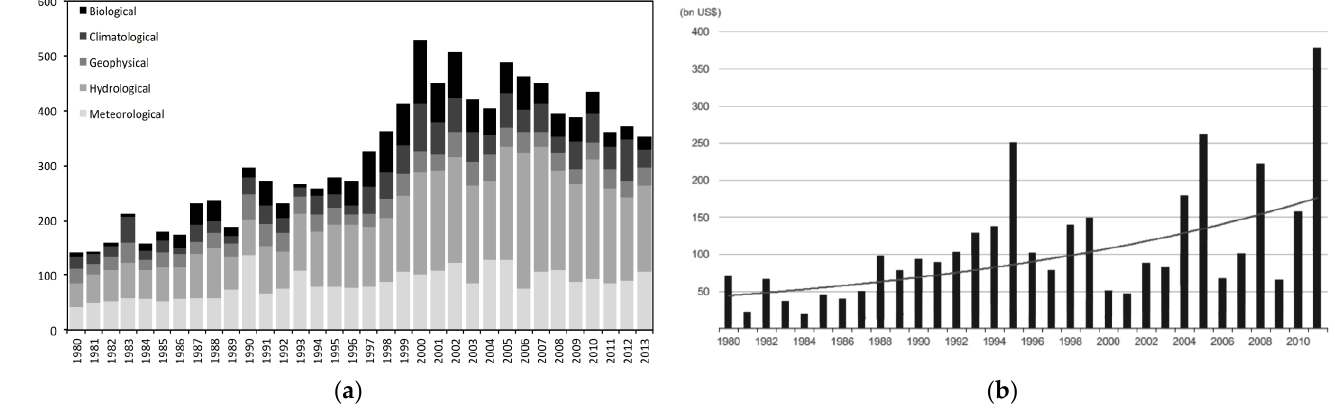
Figure 1. Natural catastrophes by ( a ) Occurrences and by ( b ) Global losses (adapted from Ref. [2]).